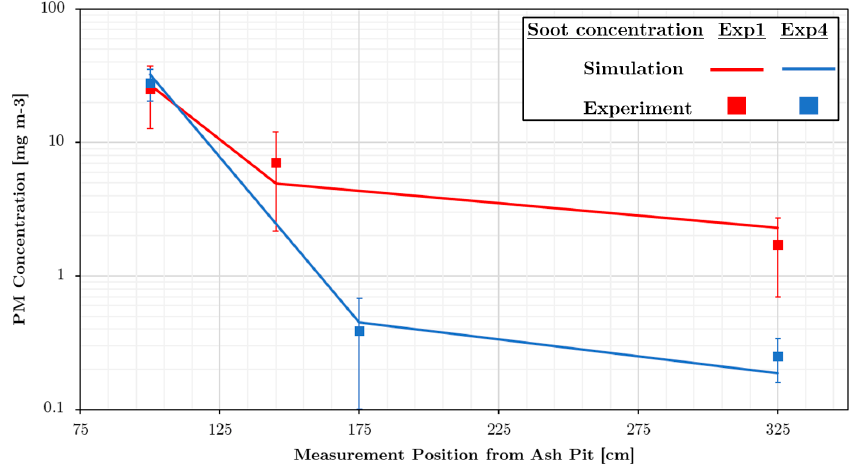
Figure 12. Comparison of experimental and calculated PM 10 concentration value from kinetic study.